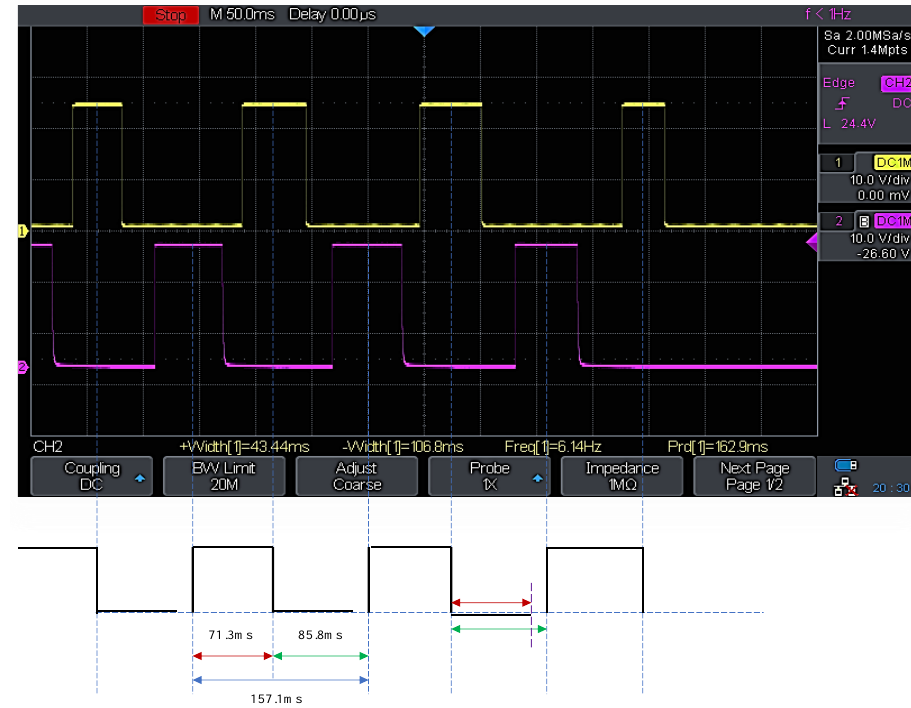
Figure 25. Digital CRO forward and reverse stroke time difference measurement.